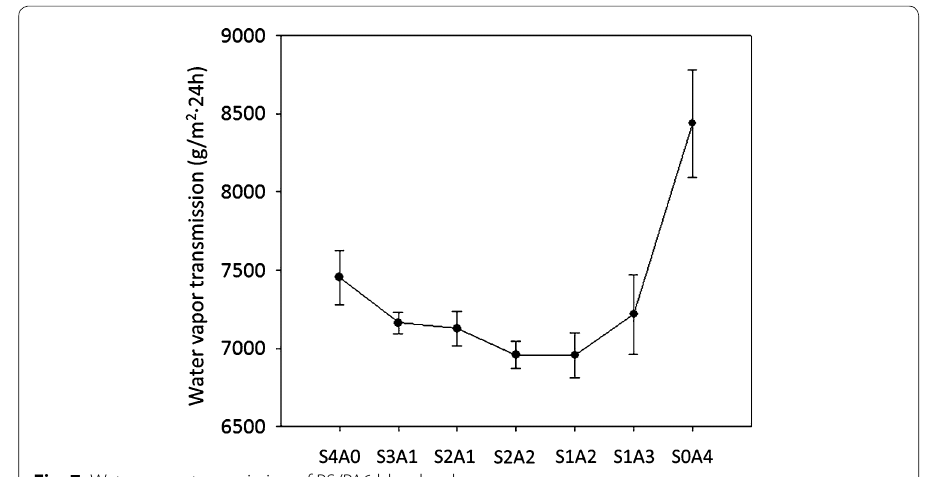
Fig. 7 Water vapor transmission of PS/PA6 blend webs